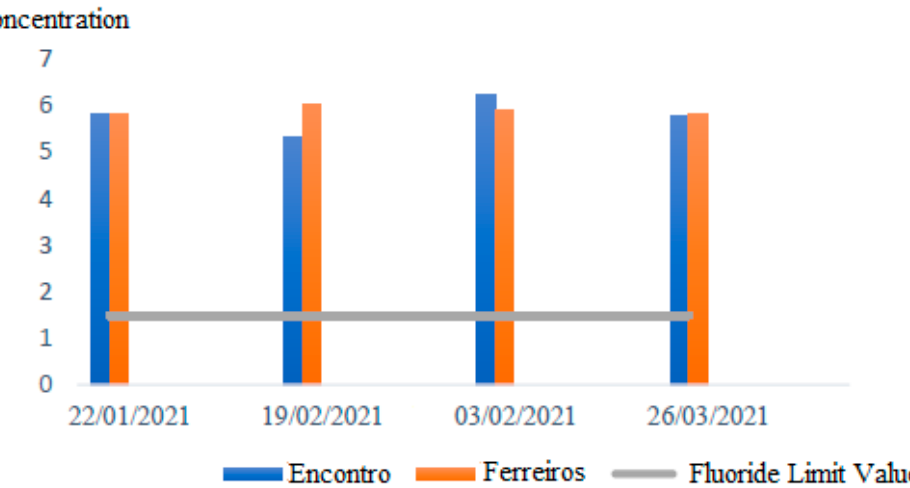
Figure 3. Comparison of the fluoride results obtained for both springs on the four selected dates with the established limit values.